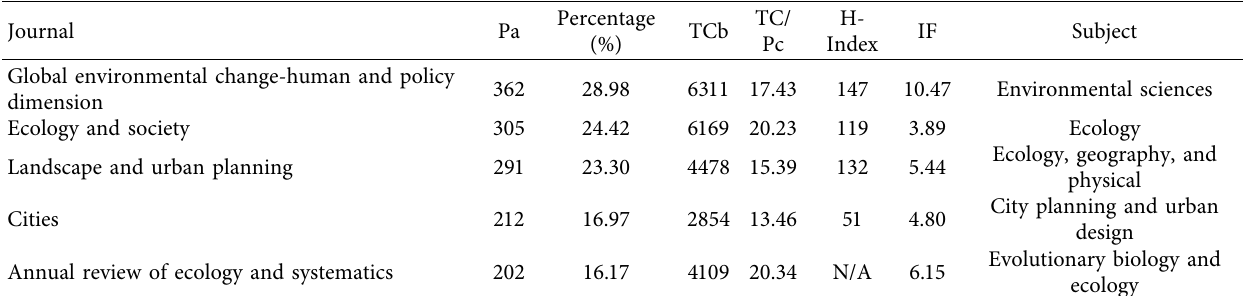
Table 4: Top 5 productive journals in the resilient city field during the period of 2010 to